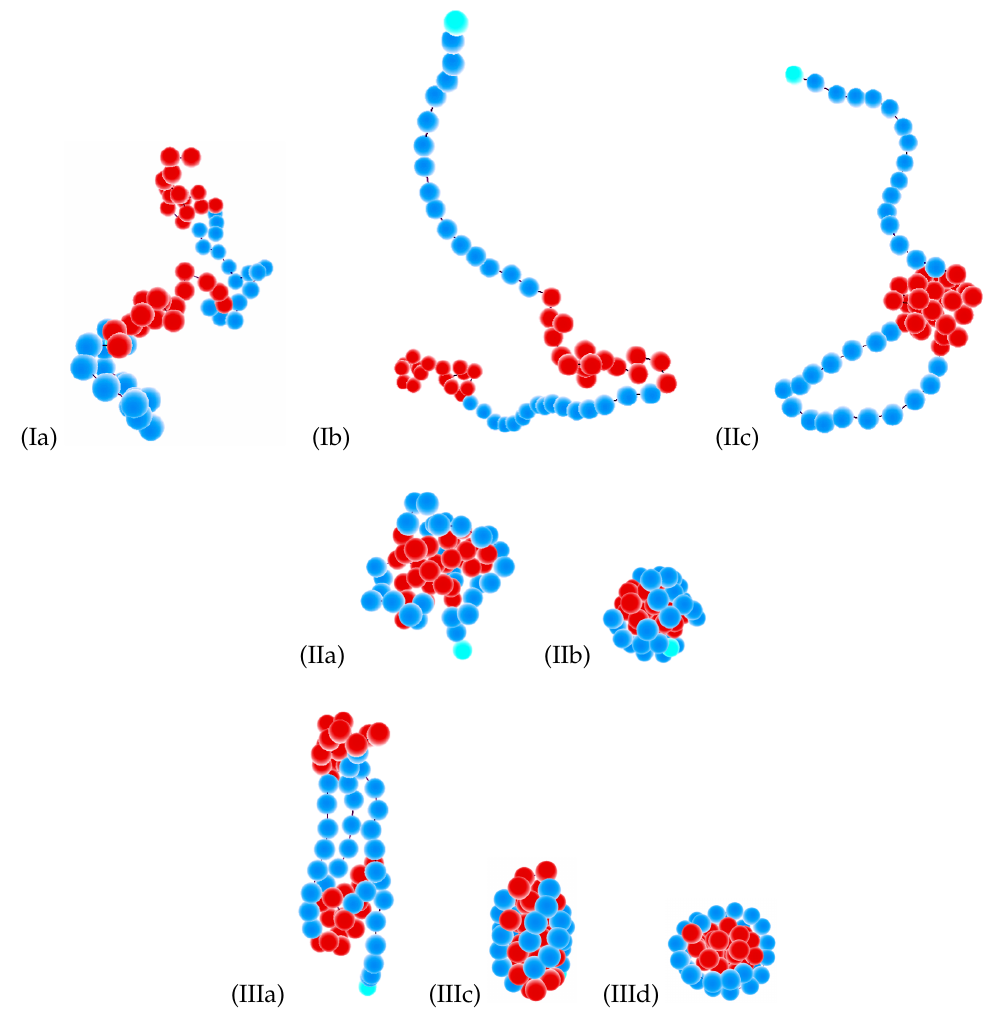
Figure 5. Selected conformations (Ia, Ib, IIa, IIb, IIc, IIIa, IIIc, IIId, indicated for each snapshot) for the case “F-attract-stronger”. Conformations Ia, Ib, IIc, and IIId are shown for a copolymer chain with block length b = 16. Conformations IIa, IIb, and IIIa are for b = 8; Conformation IIIc is for b = 4. Beads of S-blocks are blue; beads of F-blocks are